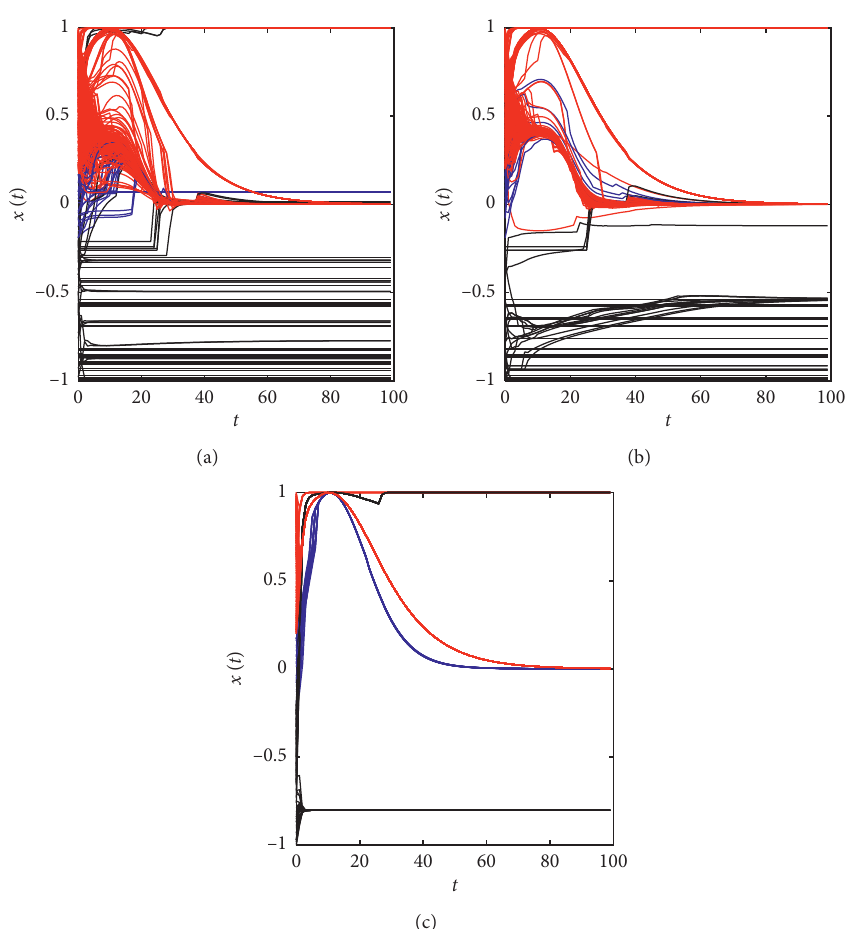
Figure 10: Impact of network topology on individual opinion reversal: (a) scale-free network; (b) small-world network; (c) random network.